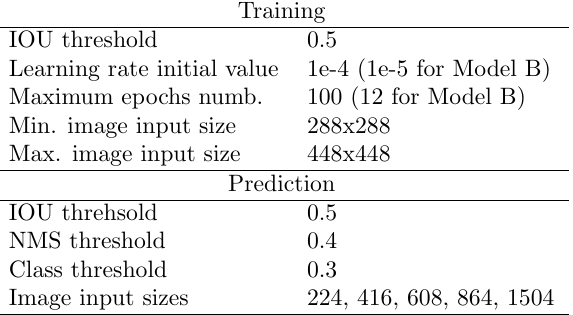
Table 1: Neural Network’s hyperparameters.